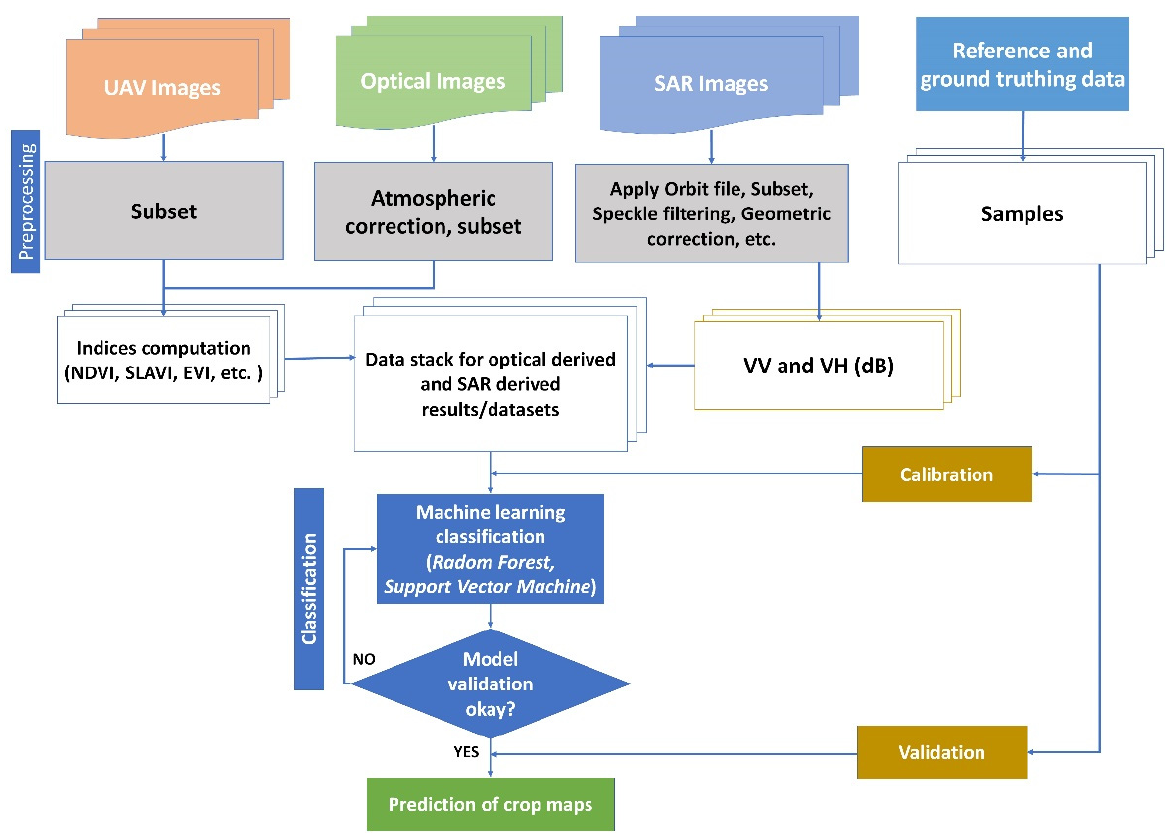
Figure 2. Workflow of unmanned aerial vehicle (UAV), synthetic aperture radar (SAR), and Sentinel 2 data processing for banana mapping.